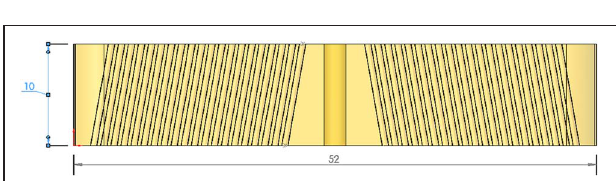
FIGURE 1 | Chamber with the removable straight grid insert. The base of the chamber will be shaped to the contours of the monkey’s skull and